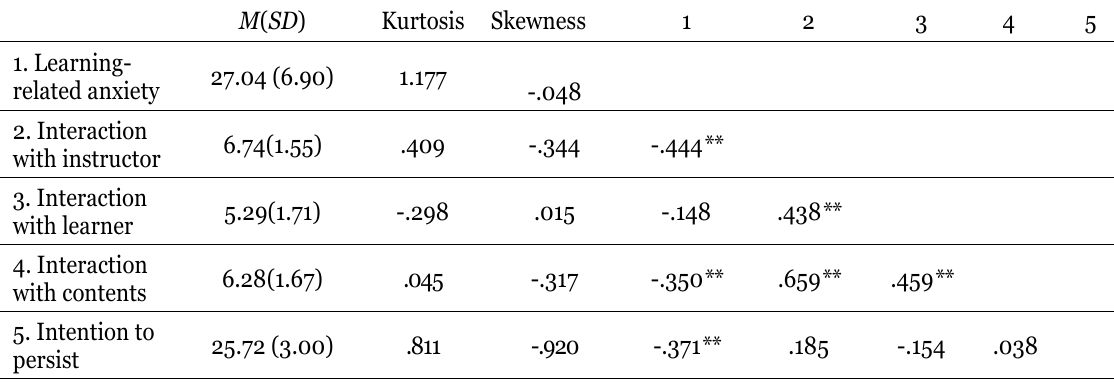
Bivariate Correlations and Descriptive Statistics for the Study Variables (n= 103) M ( SD ) Kurtosis